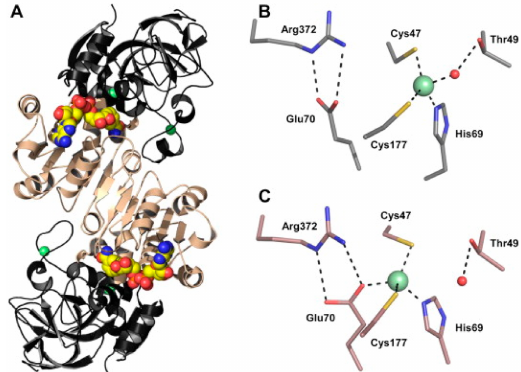
Figure 3. Solanum lycopersicum SlGSNOR shown in coordination with NAD + [6] ( A ) the active sites on the homodimer are highlighted, where the coordinated zinc is shown in green ( B , C ) a possible point of regulation in the presence of oxidative